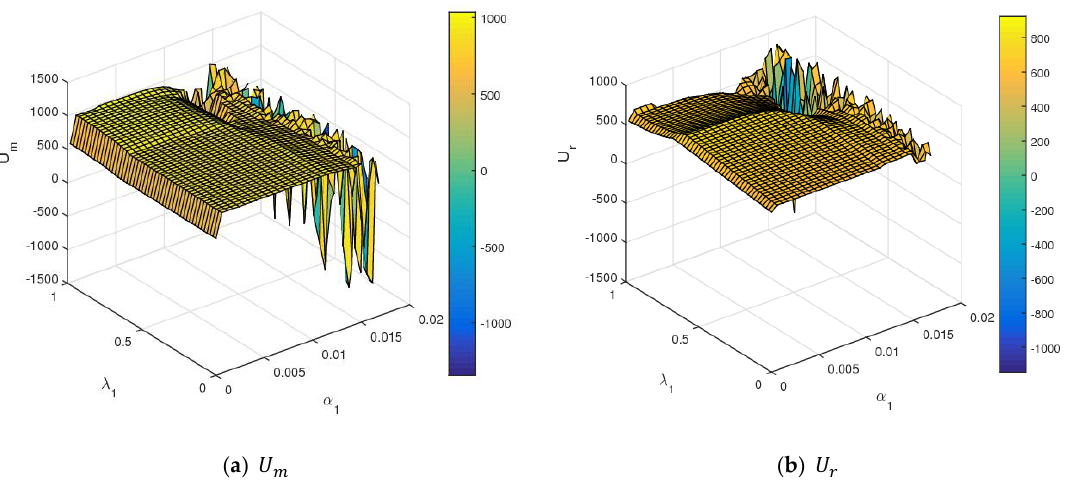
Figure 14. The utility changes of the manufacturer and retailer with respect to α 1 and λ 1 .